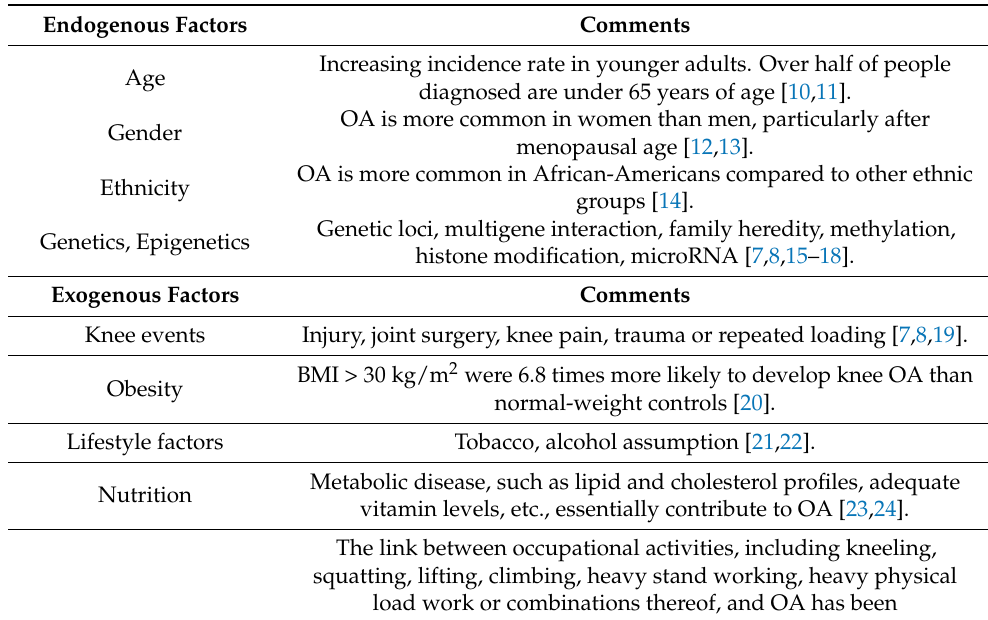
Table 1. Endogenous and exogenous risk factors of osteoarthritis